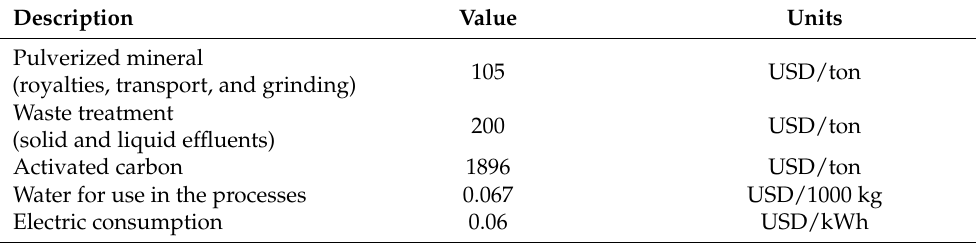
Table 6. Prices of utilities and raw materials.